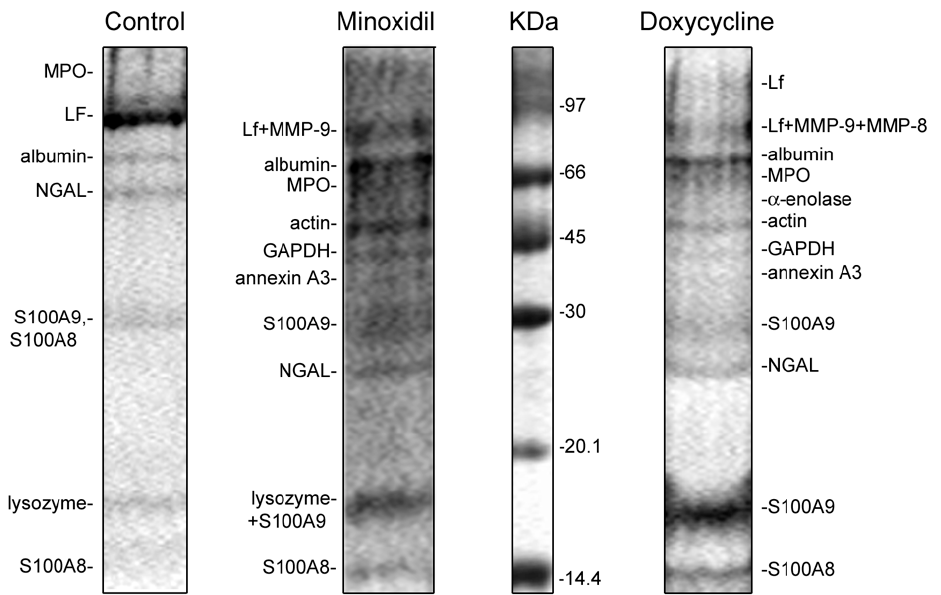
Figure 9. SDS-PAGE separation of proteins secreted by neutrophils in adherence to fibronectin in the presence of minoxidil and doxycycline. Human neutrophils were incubated over fibronectin- coated substrates for 20 min under control conditions or in the presence of 200 µ M minoxidil or 20 µ M doxycycline. Samples of extracellular medium were collected and proteins were extracted and subjected to 15% SDS-PAGE. Pictures represent typical protein profiles observed in the three independent experiments.